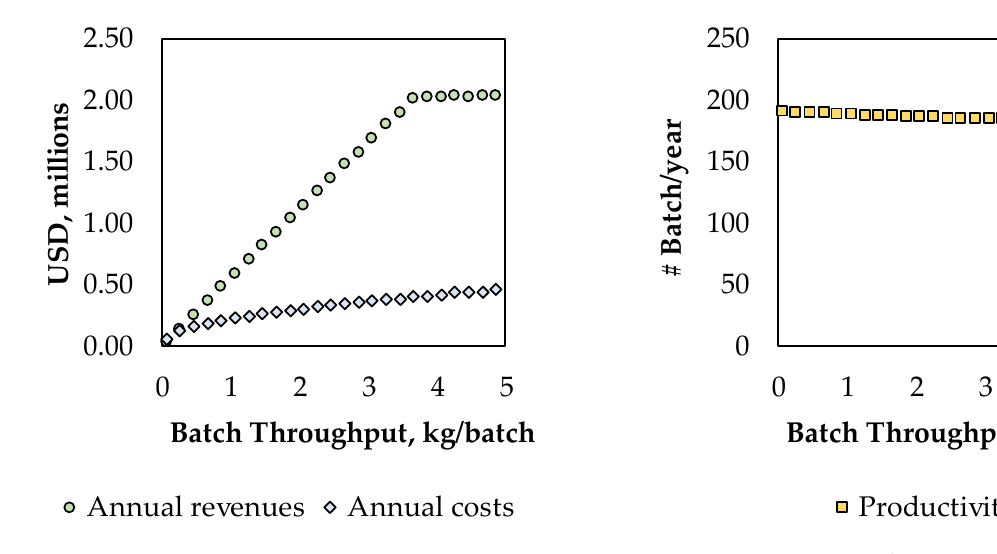
Table 6. Economic evaluation: Scenario 3 — 3 USD/g — batch throughput 3.7 kg/batch.